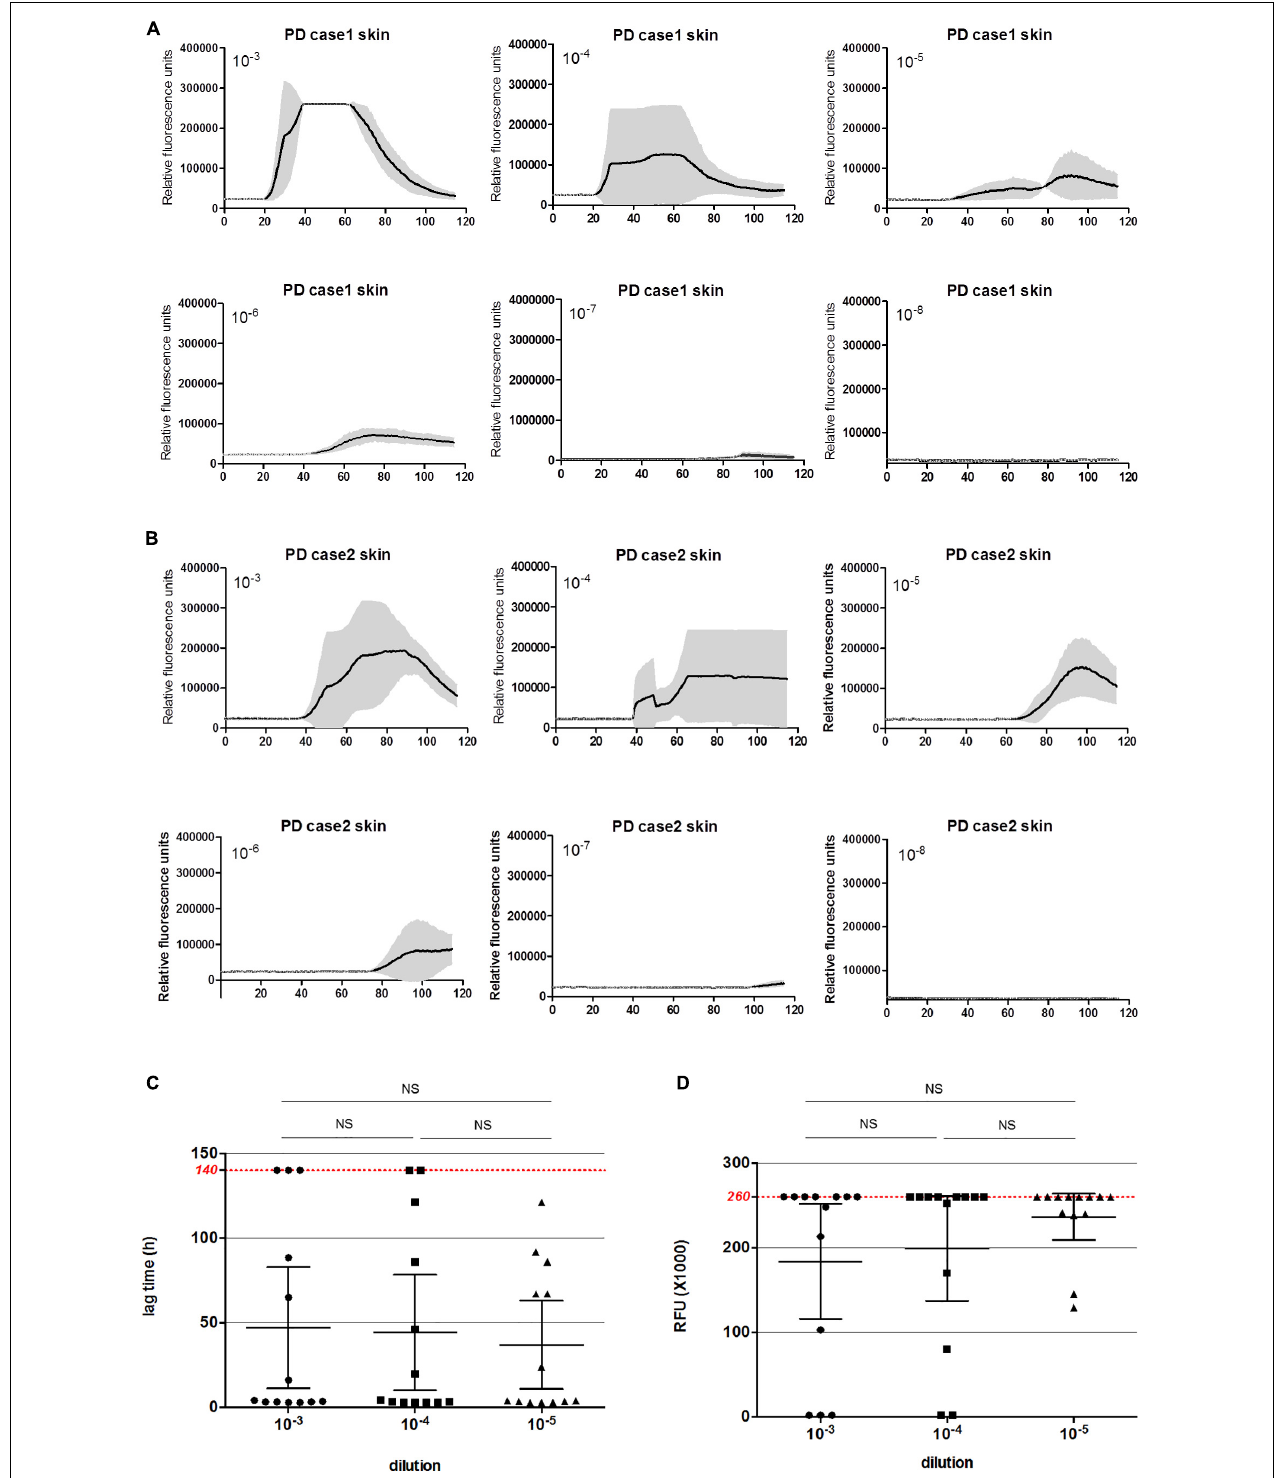
FIGURE 2 | α -Syn RT-QuIC of serially diluted skin homogenates of 13 clinical diagnosed patients with PD and 15 sCJD cases. (A) α -Syn RT-QuIC spectra of individual patients with PD. Y -axis represents rfu (ThT value). X -axis represents the time (h) post-reaction. Each reaction consists of 3 duplicates. (B) Summarized α -Syn RT-QuIC spectra of patients with sCJD. Each reaction consisted of 3 duplicates. (C) The lag times of three dilutions of the skin specimens of 13 PD cases. Maximal reaction time (140 h) is indicated with red dot line in the graph. (D) The peak rfu values of three dilutions of the skin specimens of 13 PD cases. Maximal detecting limitation of ThT value is indicated with red dot line in the graph. Ns means there is no statistical difference.